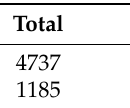
Table 3. Detailed information about the Coronahack